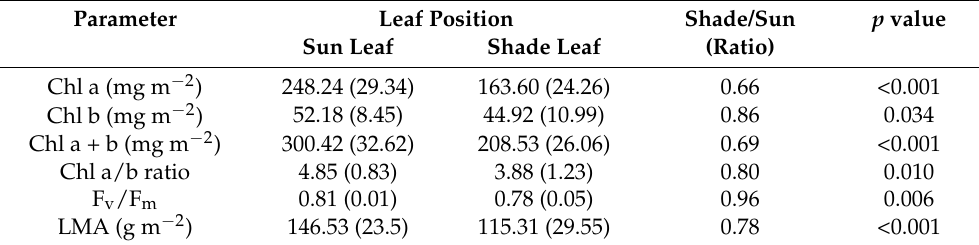
Figure 2. Relationship between N vs. ( a ) RuBisCo and N vs. ( b ) Chl concentrations in sun and shade leaves of Robinia pseudoacacia . Dashed and solid lines stand for ( a ) estimated regression lines and ( b ) means of sun and shade leaves, respectively. Table 1 . Chlorophyll (Chl) content (a, b, a + b), Chl a/b ratio, maximal quantum yield of photosystem II (F v /F m ), and leaf mass per area (LMA) for sun and shade leaves of Robinia pseudoacacia . Values represent mean (SE in parentheses). ANOVA was used to test the difference between the leaf position at the 0.05 alpha level.